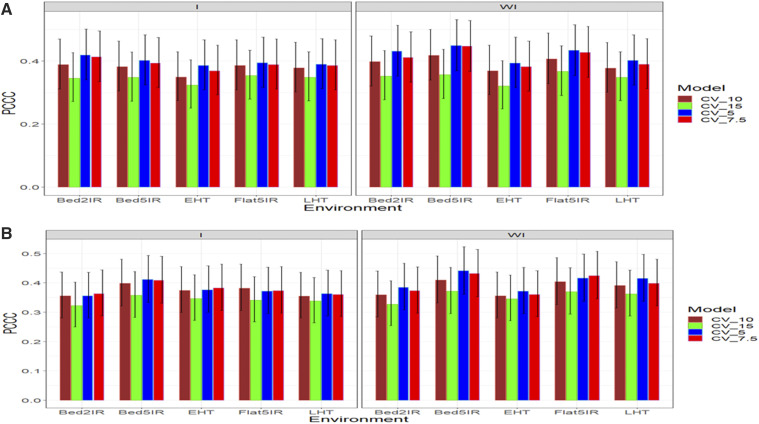
Prediction performance of the proposed MAPT model in terms of the proportion of cases correctly classified (PCCC) for traits: A) DTHD and B) DTMT of data set 2, under four values of coefficient of variation (CV). The smaller the CV, the more informative the prior. The left panel is with interaction (I) and the right panel is without interaction (WI).